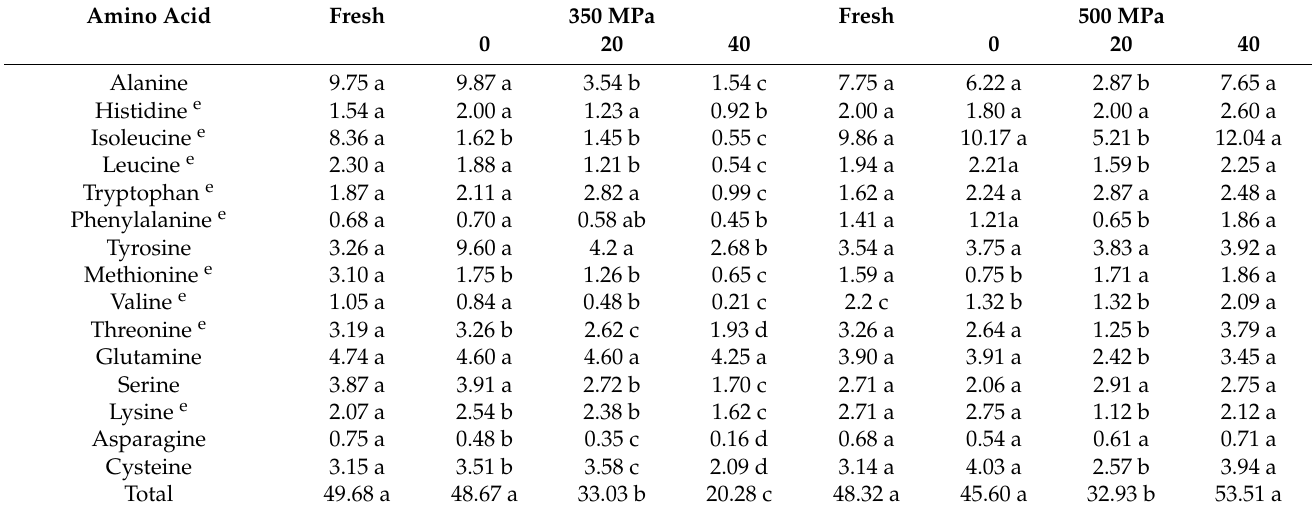
Table 6. Free amino acid composition (mg/kg) of fresh and processed gonads of P. lividus